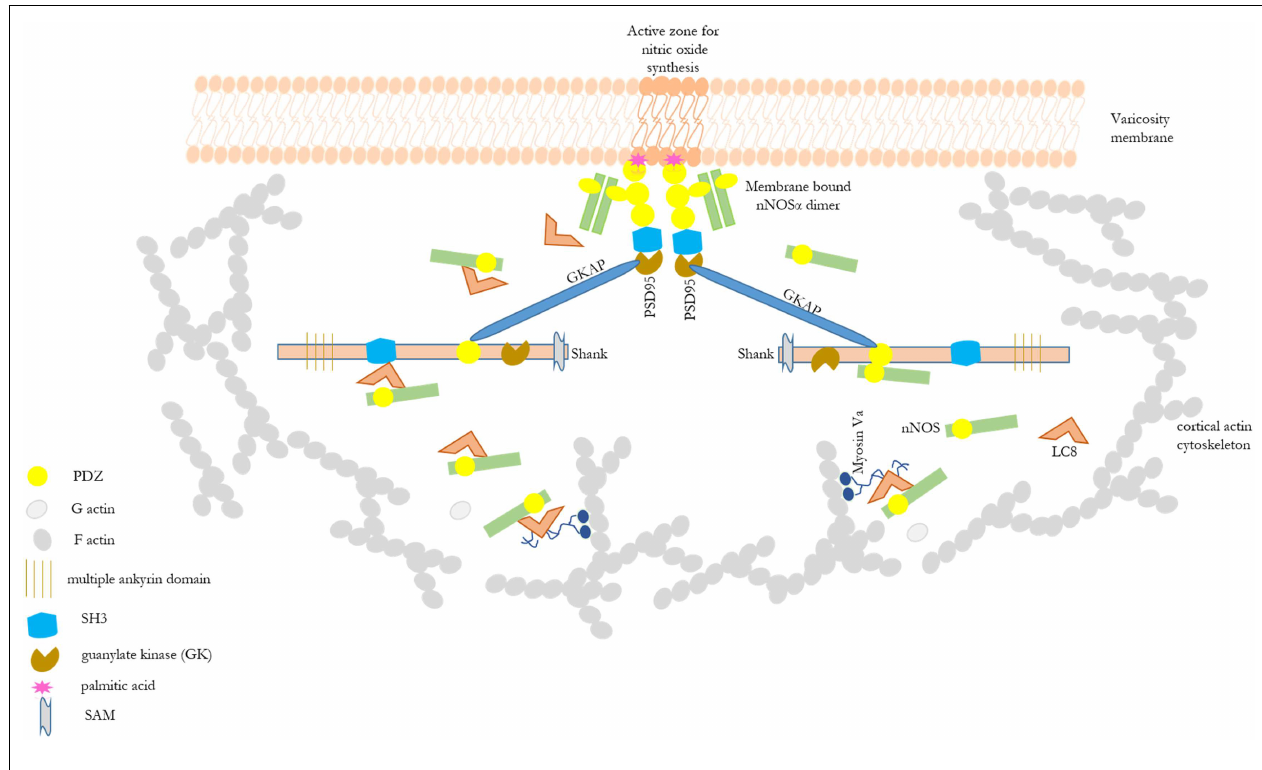
the actin cortical barrier by shank and GKAP. Shank has multiple protein interaction domains like ankyrin domains, SH3, PDZ, and SAM. Static protein interactions are planned to be examined to test whether such exchanges takes place in enteric nerve terminals. By these mechanisms, shank may play a significant role in nitric oxide synthesis and nitrergic neuromuscular neurotransmission. nNOS–LC8–myosinVa and